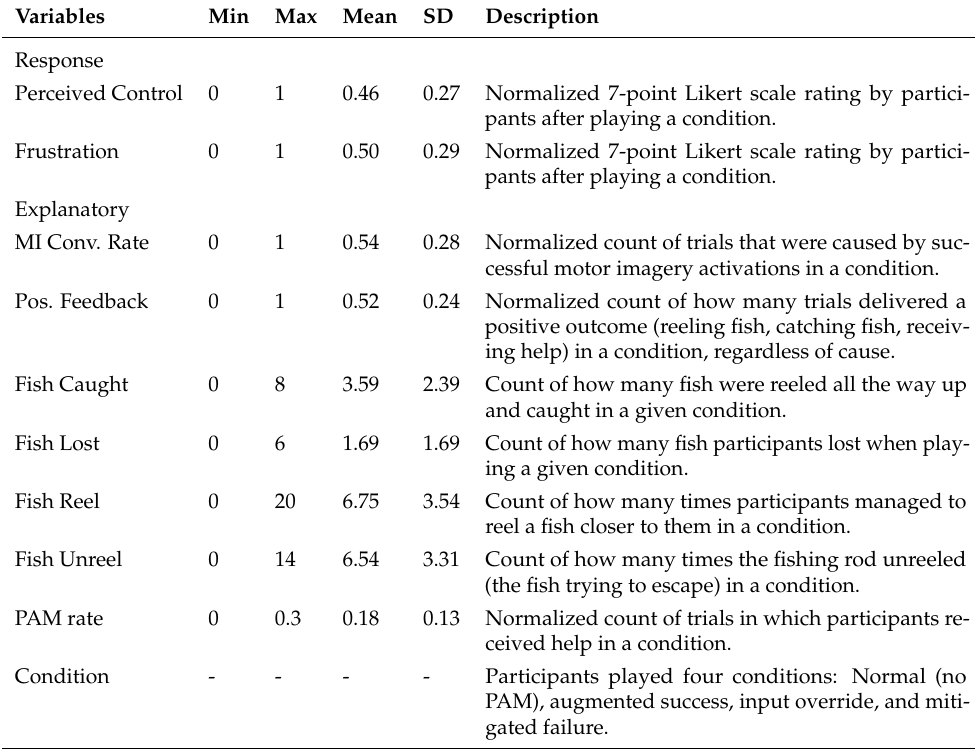
Table 2. Descriptions of dependent (response) and independent (explanatory) variables used in the analysis and their minimum (Min) and maximum values (Max), means, and standard deviation(s) (SD). Variables Min